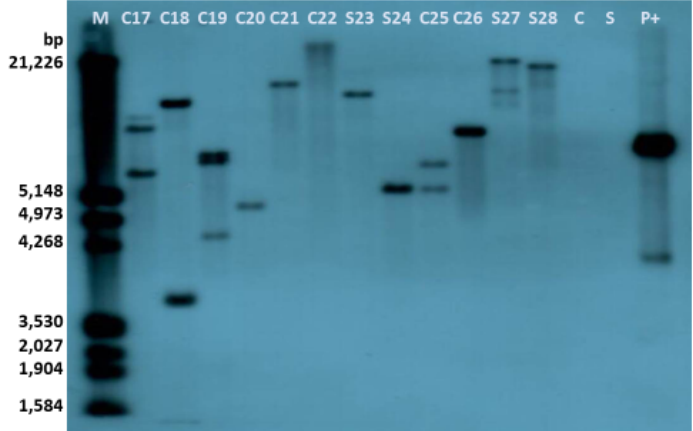
Figure 2. Southern blot analysis using a probe of the man A coding region: C17-22, C25-26 : Citrus sinensis Osb. x Poncirus trifoliata L. Raf. (‘Carrizo’ citrange) transgenic lines digested with Eco